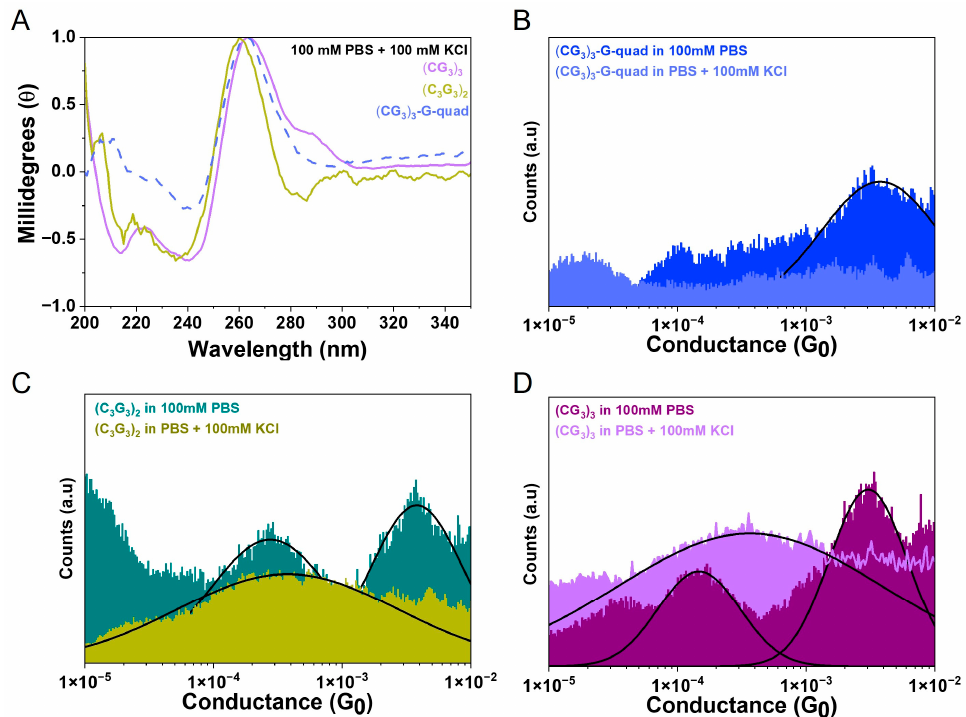
Figure 5. CD and conductance histograms for DNA hybrids ( A ) CD spectra in 100 mM PBS with 100 mM KCl for (CG 3 ) 3 -G-quad (dashed line), (CG 3 ) 3 (light magenta) and (C 3 G 3 ) 2 (dark yellow). ( B ) conductance histograms for (CG 3 ) 3 -G-quad in 100 mM PBS (blue) and 100 mM PBS + 100 mM KCl (light blue). ( C ) Conductance histograms for (C 3 G 3 ) 2 in 100 mM PBS (dark cyan) and 100 mM PBS + 100 mM KCl (dark yellow). ( D ) Conductance histograms for (CG 3 ) 3 in 100 mM PBS (purple) and 100 mM PBS + 100 mM KCl (light purple). All peaks are fit with a gaussian distribution in log scale.